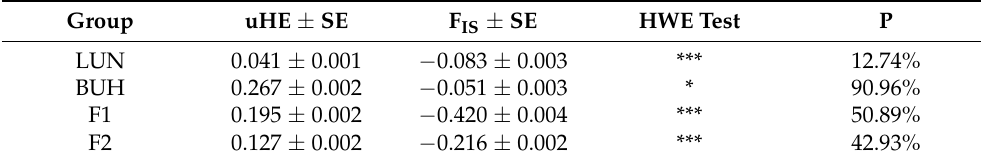
Table 2. Indices of genetic diversity per group: Lundehund (LUN), Buhund (BUH), first-generation crosses LUN × BUH (F1) and first-generation backcrosses F1 × LUN (F2). The table presents the unbiased expected heterozygosity (uH E ) and inbreeding coefficient (F IS ) and their respective standard errors, the Hardy–Weinberg test (HWE) and the mean percentage of polymorphic loci (P). Group uHE ± SE F IS ± SE HWE Test P LUN 0.041 ± 0.001 − 0.083 ± 0.003 *** 12.74% BUH 0.267 ± 0.002 − 0.051 ± 0.003 * 90.96% F1 0.195 ± 0.002 − 0.420 ± 0.004 *** 50.89% F2 0.127 ± 0.002 − 0.216 ± 0.002 *** 42.93% *** p < 0.001, * p <